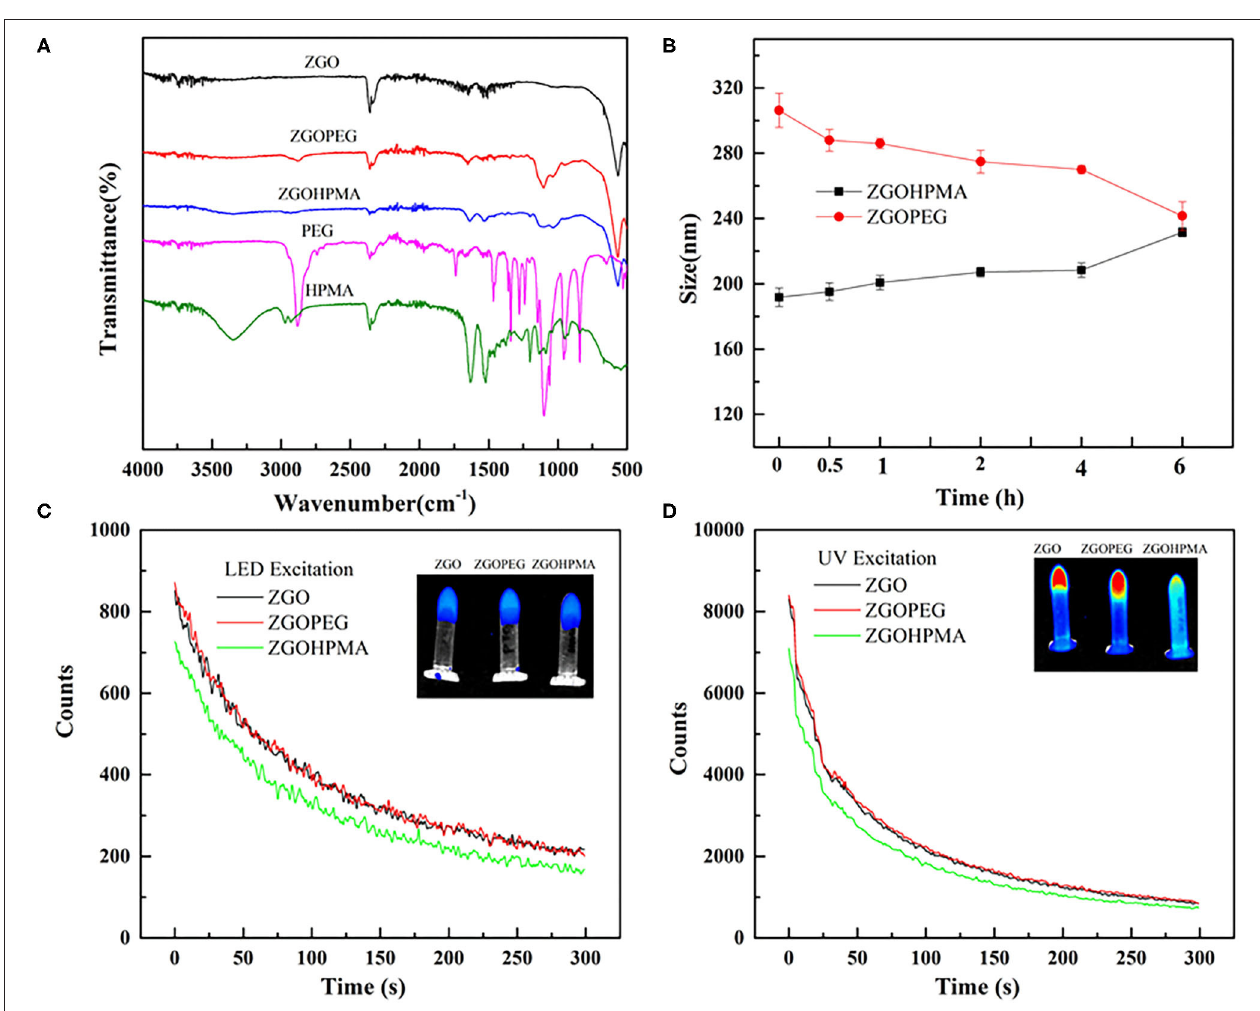
FIGURE 4 | Physico-chemical characterizations of functionalized ZGO. (A) FT-IR spectra of polymers and ZGO-HPMA and ZGO-PEG. (B) Colloidal stability of ZGO-HPMA and ZGO-PEG in glucose. (C) Persistent luminescence decay after visible excitation. (D) Persistent luminescence decay after UV excitation.